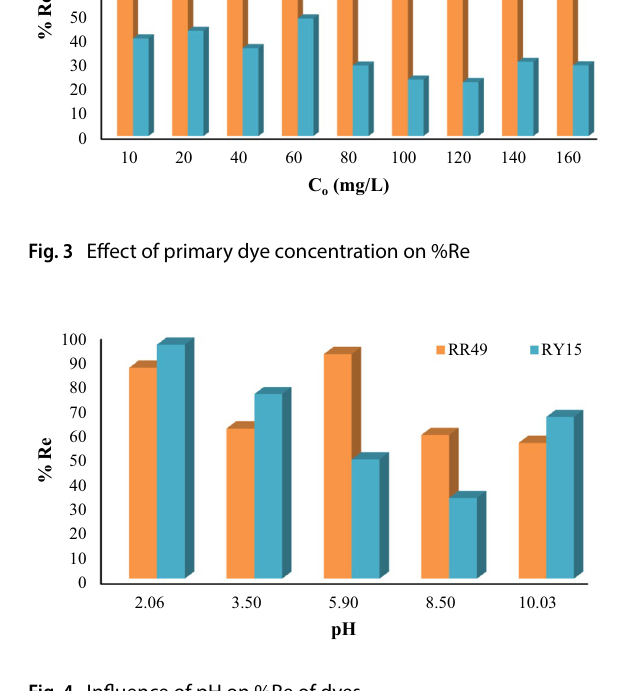
Fig. 4 Influence of pH on %Re of